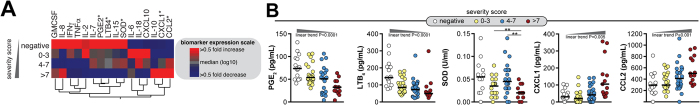
Distinct expression of immune and inflammatory markers in serum from dogs presenting with different VL clinical severity scores.(A) Hierarchical cluster analysis (Ward’s method) with bootstrap was performed to depict the overall expression profile of the indicated serum biomarkers in the different study groups. (B) Scatter plots of biomarkers displaying significant statistical differences (P < 0.005) between the study groups using Kruskal-Wallis test. Non-parametric linear trend ad hoc tests were employed to examine the variation of the biomarker levels following the clinical severity score. SOD levels did not exhibit linear trend, thus data were compared using the Dunn’s multiple comparisons test (**P < 0.01).